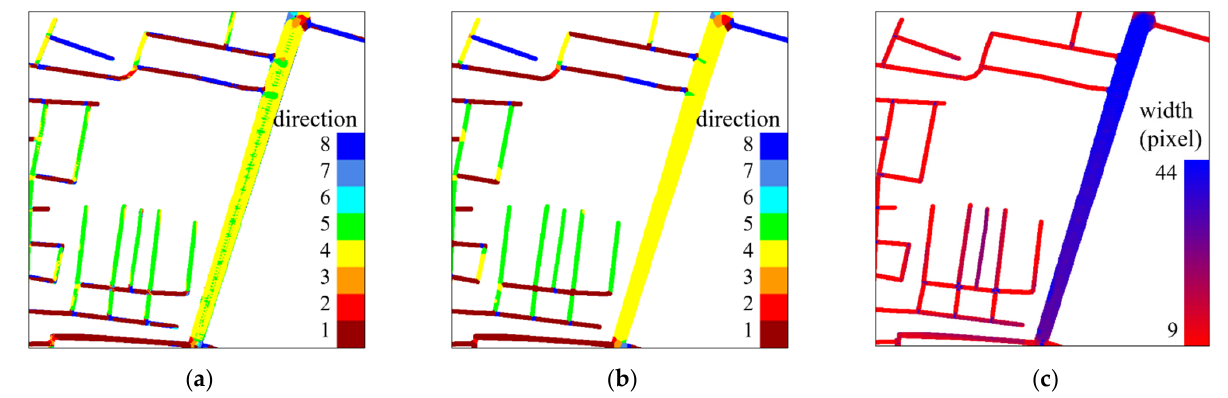
Figure 3. Detected feature maps from a sample road binary map. ( a ) Detected direction map ( N = 8). ( b ) Refined direction map using MRF. ( c ) Detected width map.